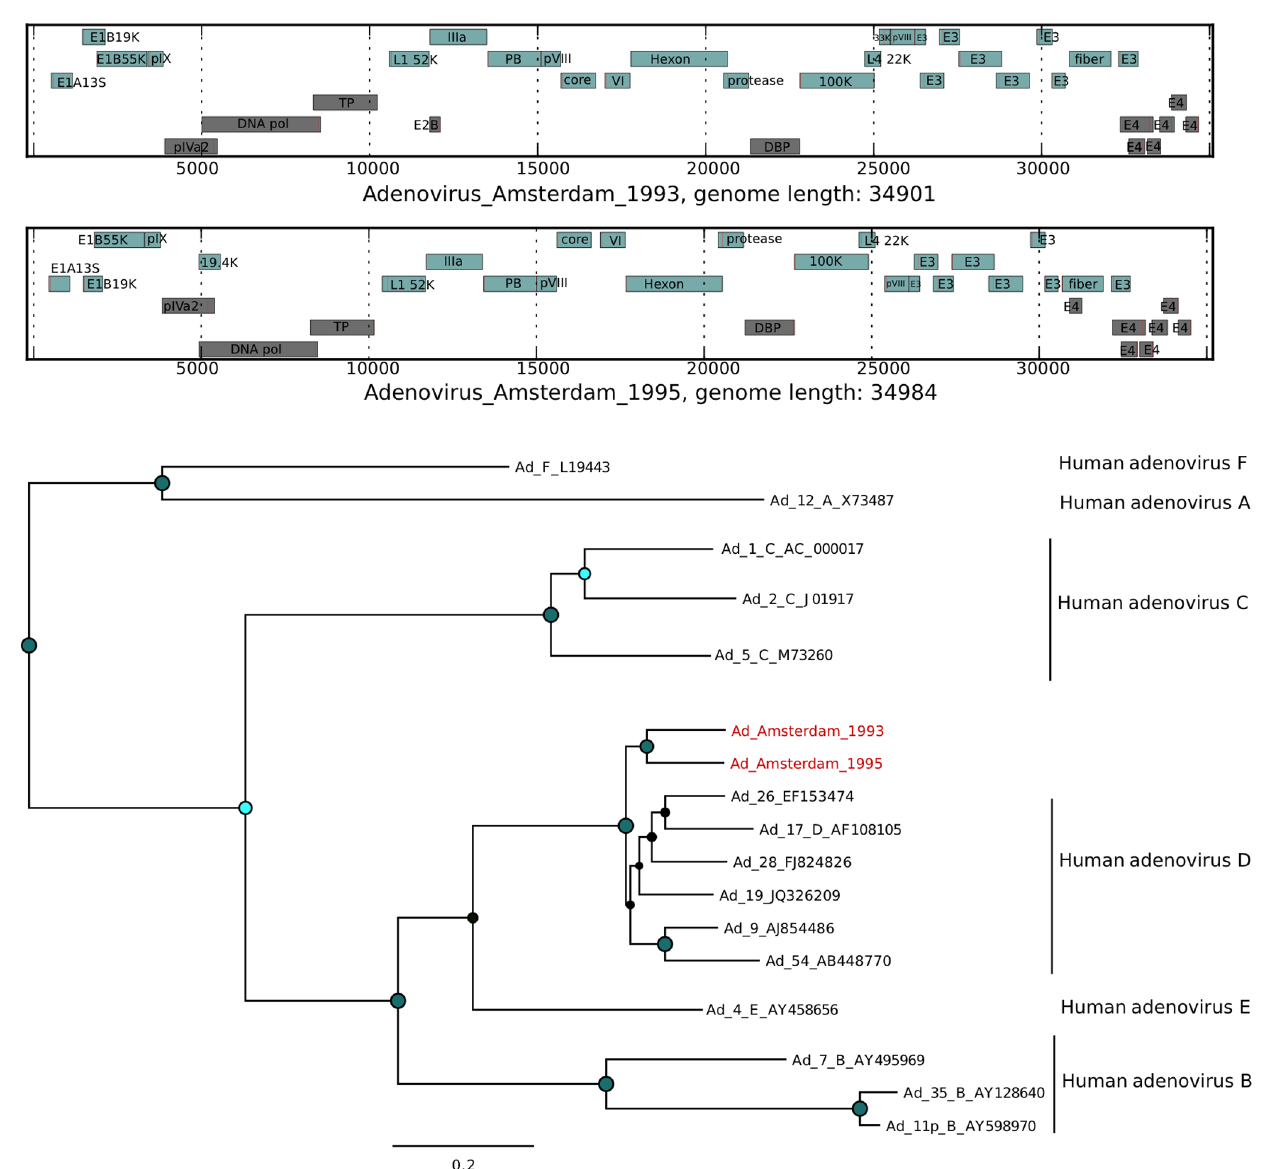
Figure 7. Open reading frame structure and phylogenetic analysis of the adenovirus genomes identified in this study. The ORF pattern of the full genomes grey (for all ORFs . 100 amino acids in length), with the initial ATG in each ORF (vertical red bar) and all stop codons (vertical black bars) are indicated. For clarity the stop codon positions were not marked in the adenovirus genomes. Also shown are the maximum likelihood trees inferred using PhyML version 3.0 under the general-time reversible substitution model. Among-site heterogeneity was considered through a discrete-gamma distribution model, and the robustness of the phylogeny assessed through bootstrap analysis of 1000 pseudo-replicates. The trees are marked with green node circles indicating the bootstrap support, (small green circle at 70% support, larger green circle at 100% support, black nodes indicate support below 70%). The genomes identified in this study are marked in red.